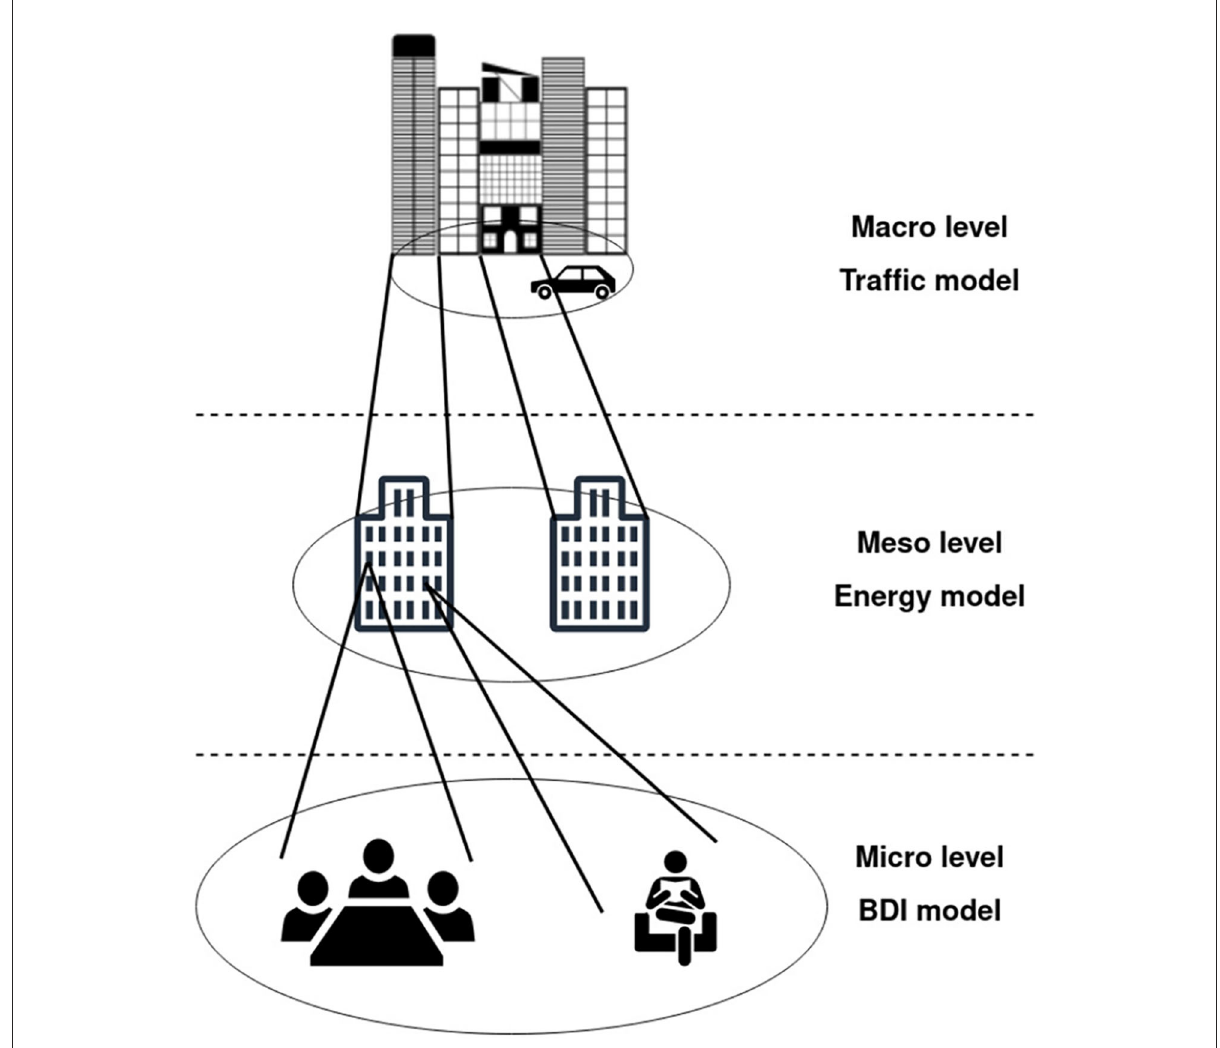
FIGURE4 Simplified representation of the Russian Dolls